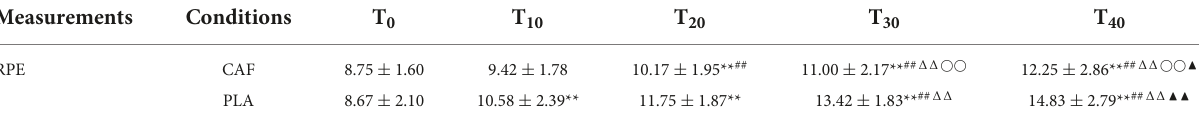
TABLE 3 Changes in RPE during exercise in both